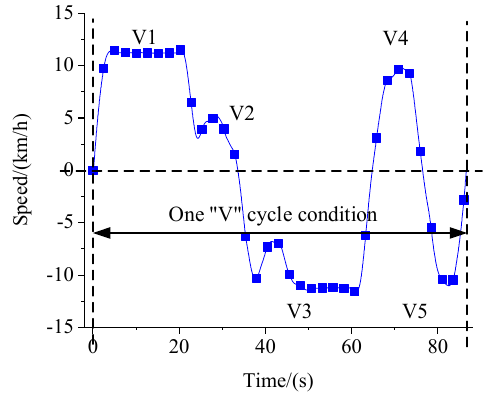
Figure 17. Data of the driving speed.